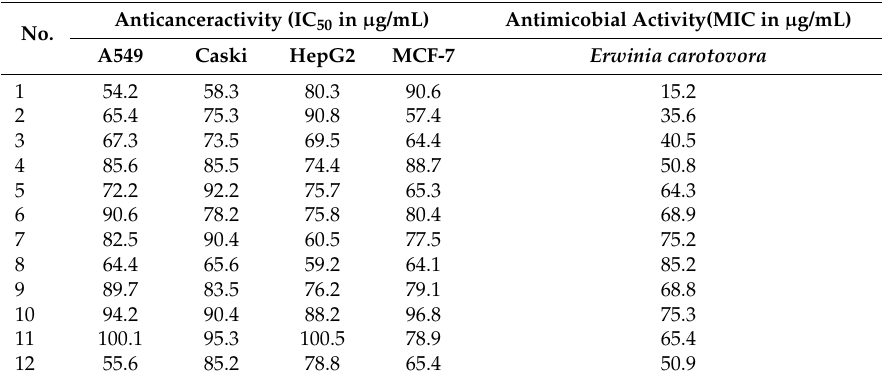
Table 3. The biological activity assays data of 1 – 12